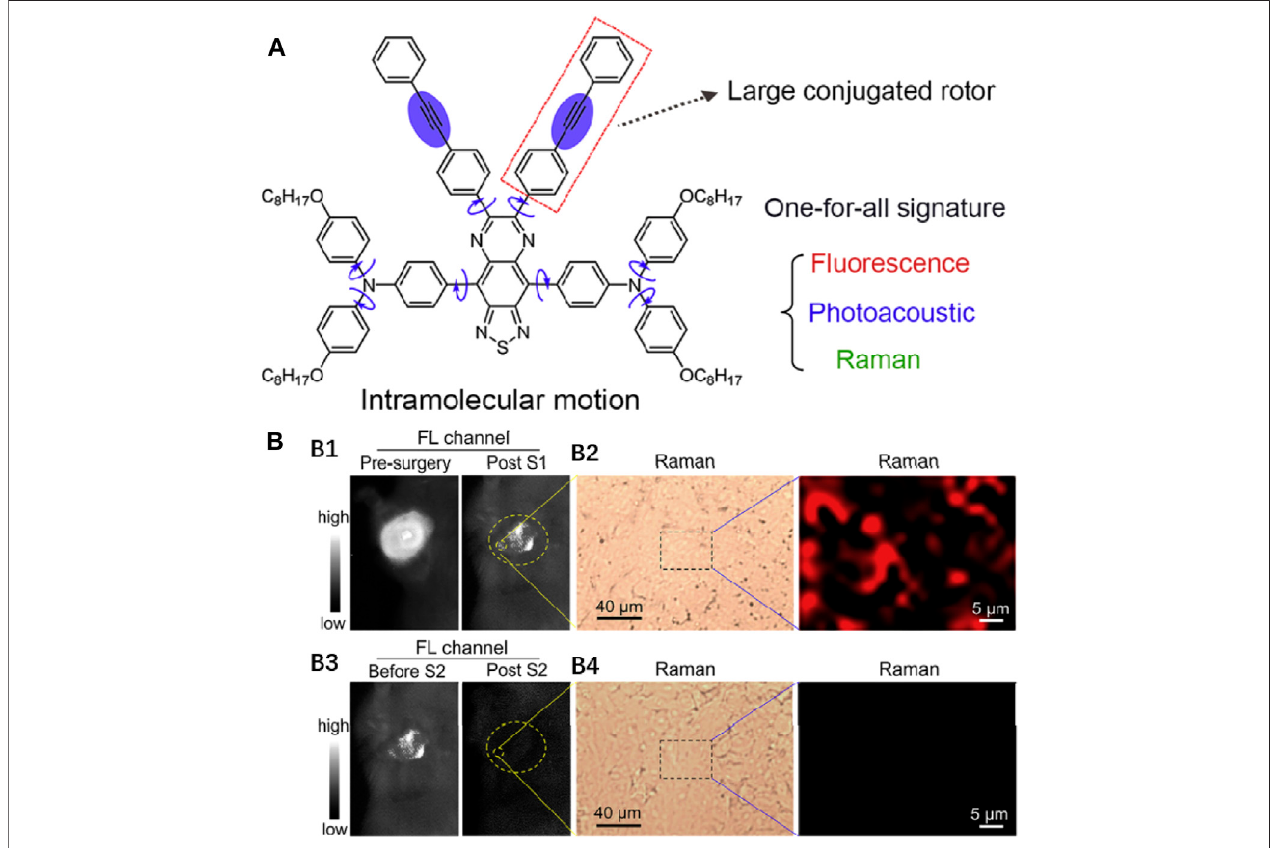
FIGURE5 |(A) Chemical structure ofOTPA-TQ3. Adapted withpermission from Qiet al. (2019). (B) Representative fl uorescence images (B1) and Raman images (B2) of the OTPA-TQ3 NPs-handled tumor-bearing mice before and after the fi rst surgery. Representative fl uorescence images (B3) and Raman images (B4) of the OTPA-TQ3 NPs-handled tumor-bearing mice before and after the second surgery.